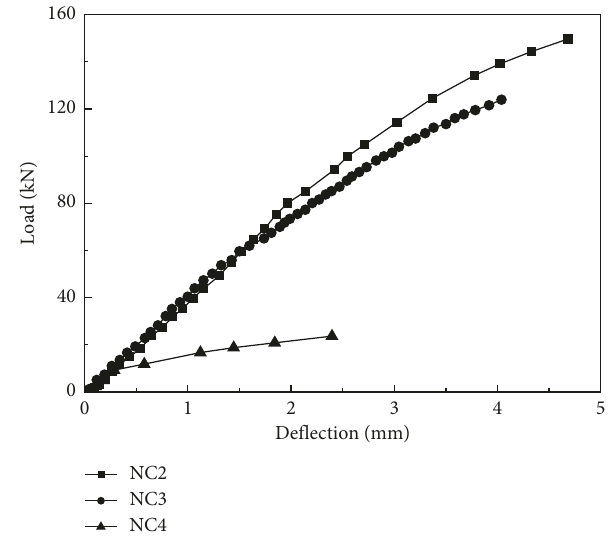
Figure 7: Specimen load-deflection curve.